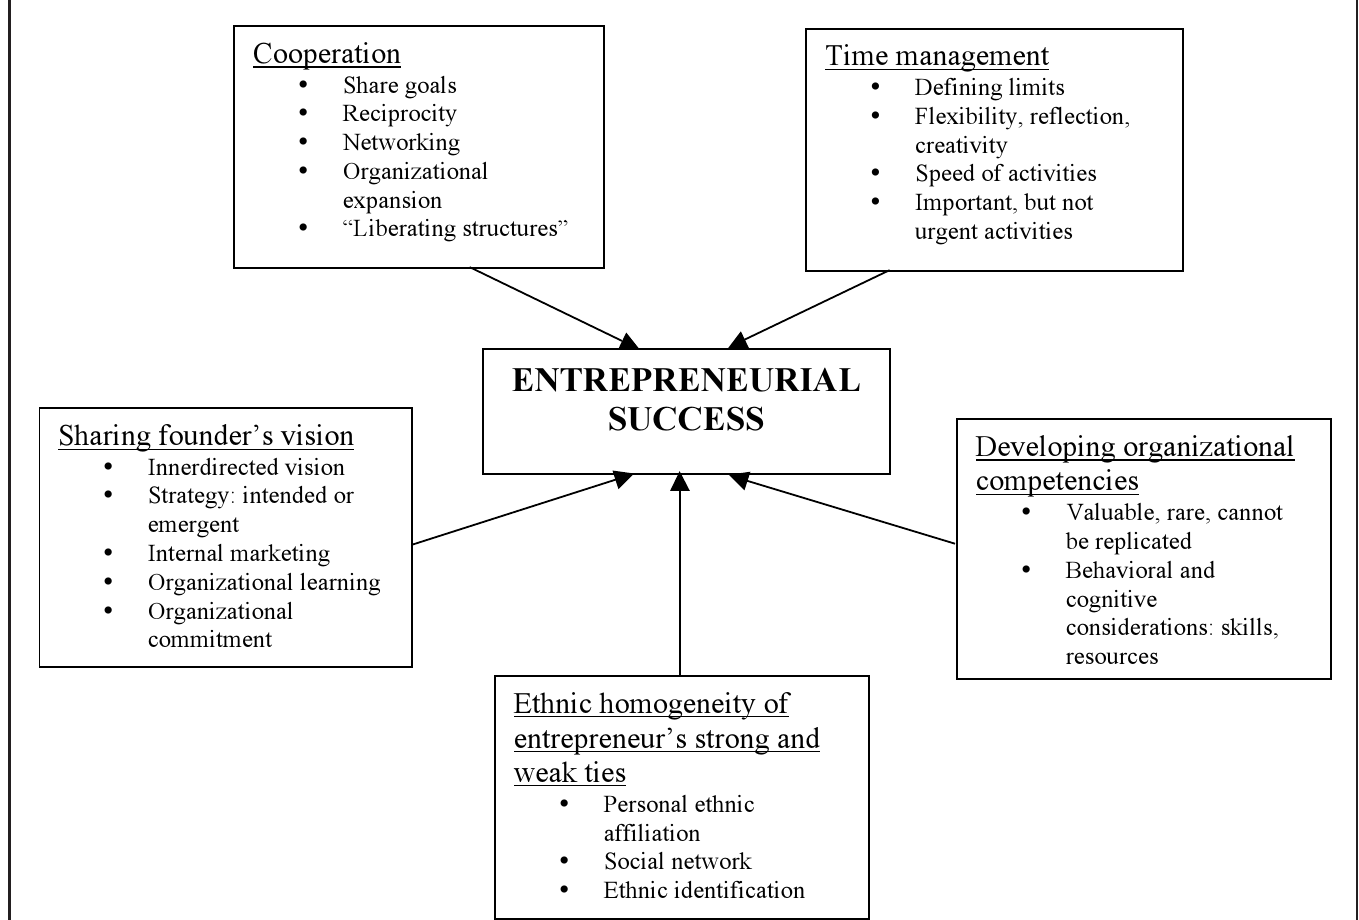
Figure 1. Modeling Entrepreneurial